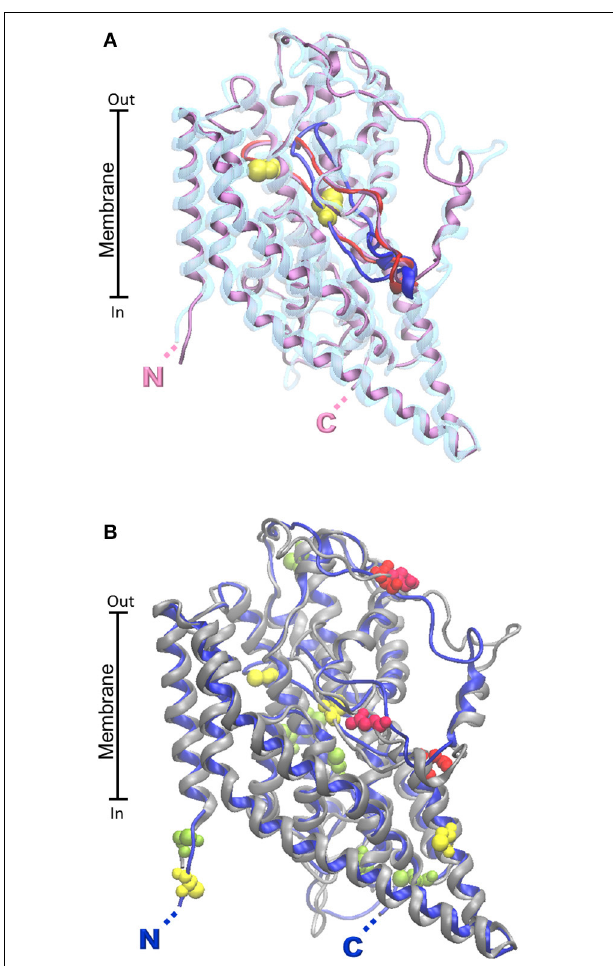
FIGURE 4 | Homology models of ASCT2 human and rat transporters. The homology structural models of rat and human ASCT2 were obtained by the Modeler 9.13 software (Sali and Blundell, 1993) using as template the structure (PDB 1XFH) of the glutamate transporter homolog from P. horikoshii (Glpth). To run the software, sequences were aligned by ClustalX2 software with .pir output format. RMSD for model comparison was calculated by Spdbv 4.1.0. Superposition of the rat and human structural models was performed by VMD 1.9.1. (A) The human protein (transparent) contains a variable loop in bleu, the rat one (purple) contains a variable loop in red. The Cys residues of the CXXC metal binding motif present only in the rat protein are highlighted in yellow. (B) The human protein is in gray; the rat one is in bleu. Putative glycosylation sites of both proteins are highlighted in red. Cysteine residues common to the two orthologous proteins are highlighted in light green. Additional Cys residues present only in rat protein are highlighted in yellow. N- and C- terminals of rat and human proteins are nearly coincident and highlighted by single N and